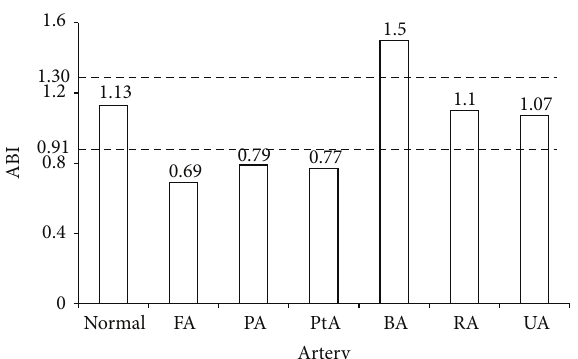
Figure 5: ABI for the normal case and for the stenosis cases with severities of 70% at 6 arteries, respectively. FA (femoral artery), PA (popliteal artery), PtA (posterior tibial artery), BA (brachial artery), RA (radial artery), and UA (ulnar artery) denote the locations of the stenoses. The dotted lines represent the evaluation standards of normal ABI (0.91 ∼ 1.30) proposed by ACC/AHA. Vascular stenoses may have occurred if the value of ABI exceeds this